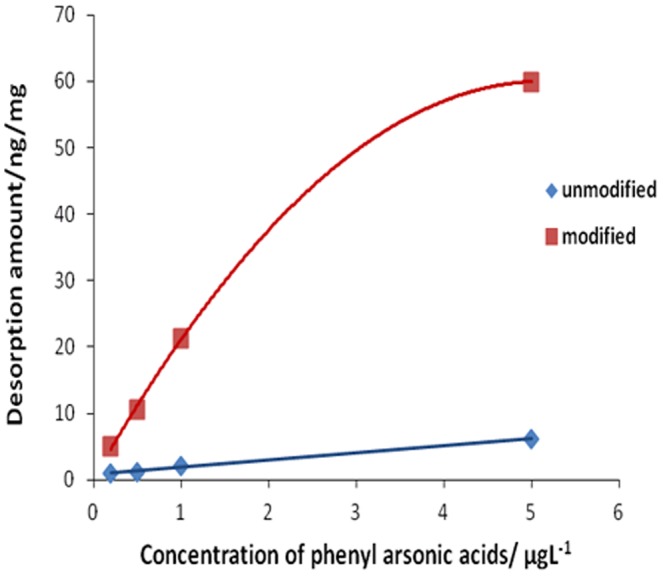
Comparison of Fe3O4 nanoparticles (blue diamond) and CM-a-CD-Fe3O4 nanoparticles for adsorption of ROX (red square).